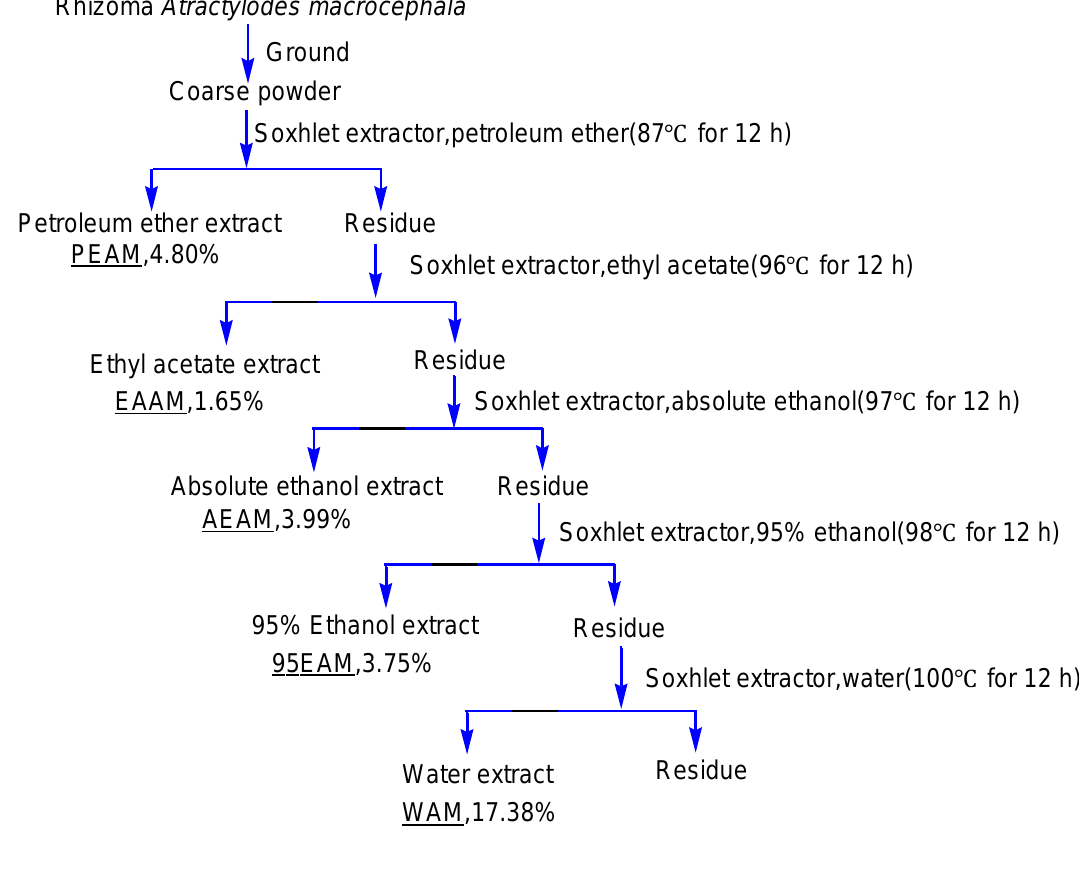
Figure 2. The preparation of five extracts from Rhizoma Atractylodes macrocephala . Rhizoma Atractylodes macrocephala